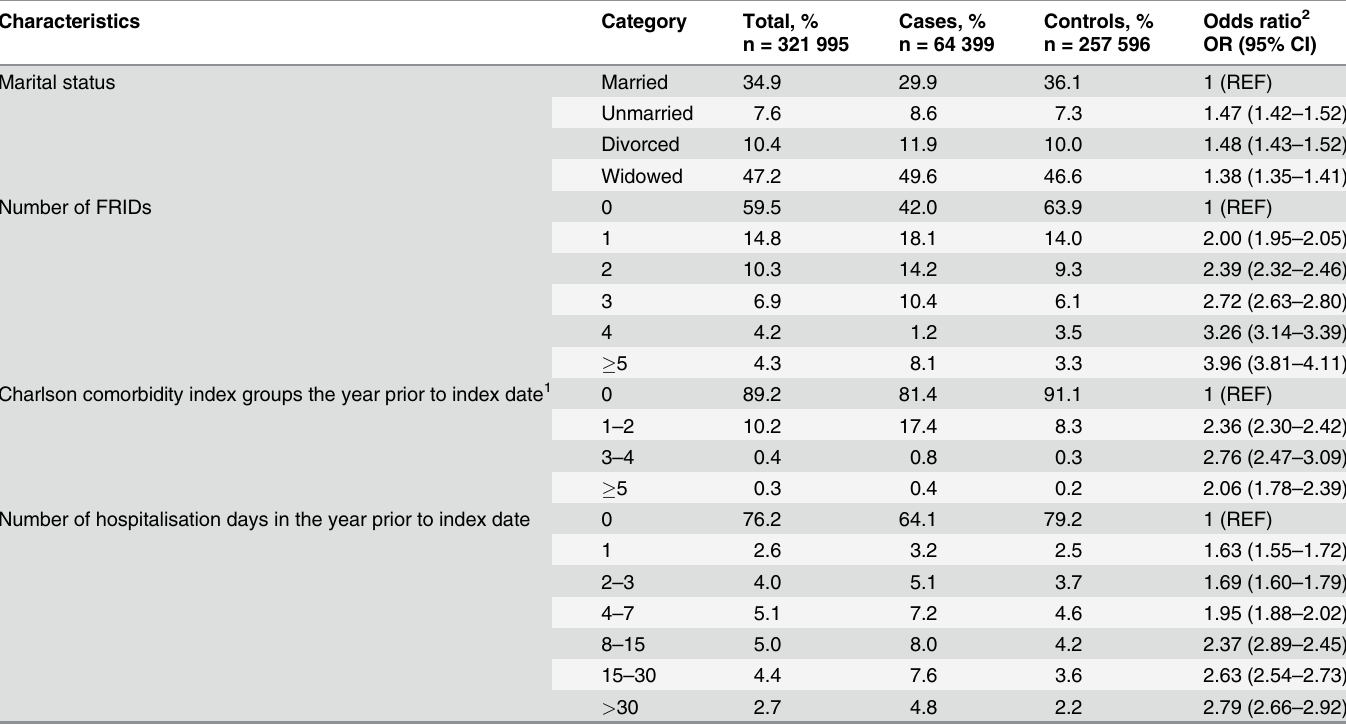
Table 1. Characteristics (%) of the Study Population, Stratified by Case and Control Status, n = 321